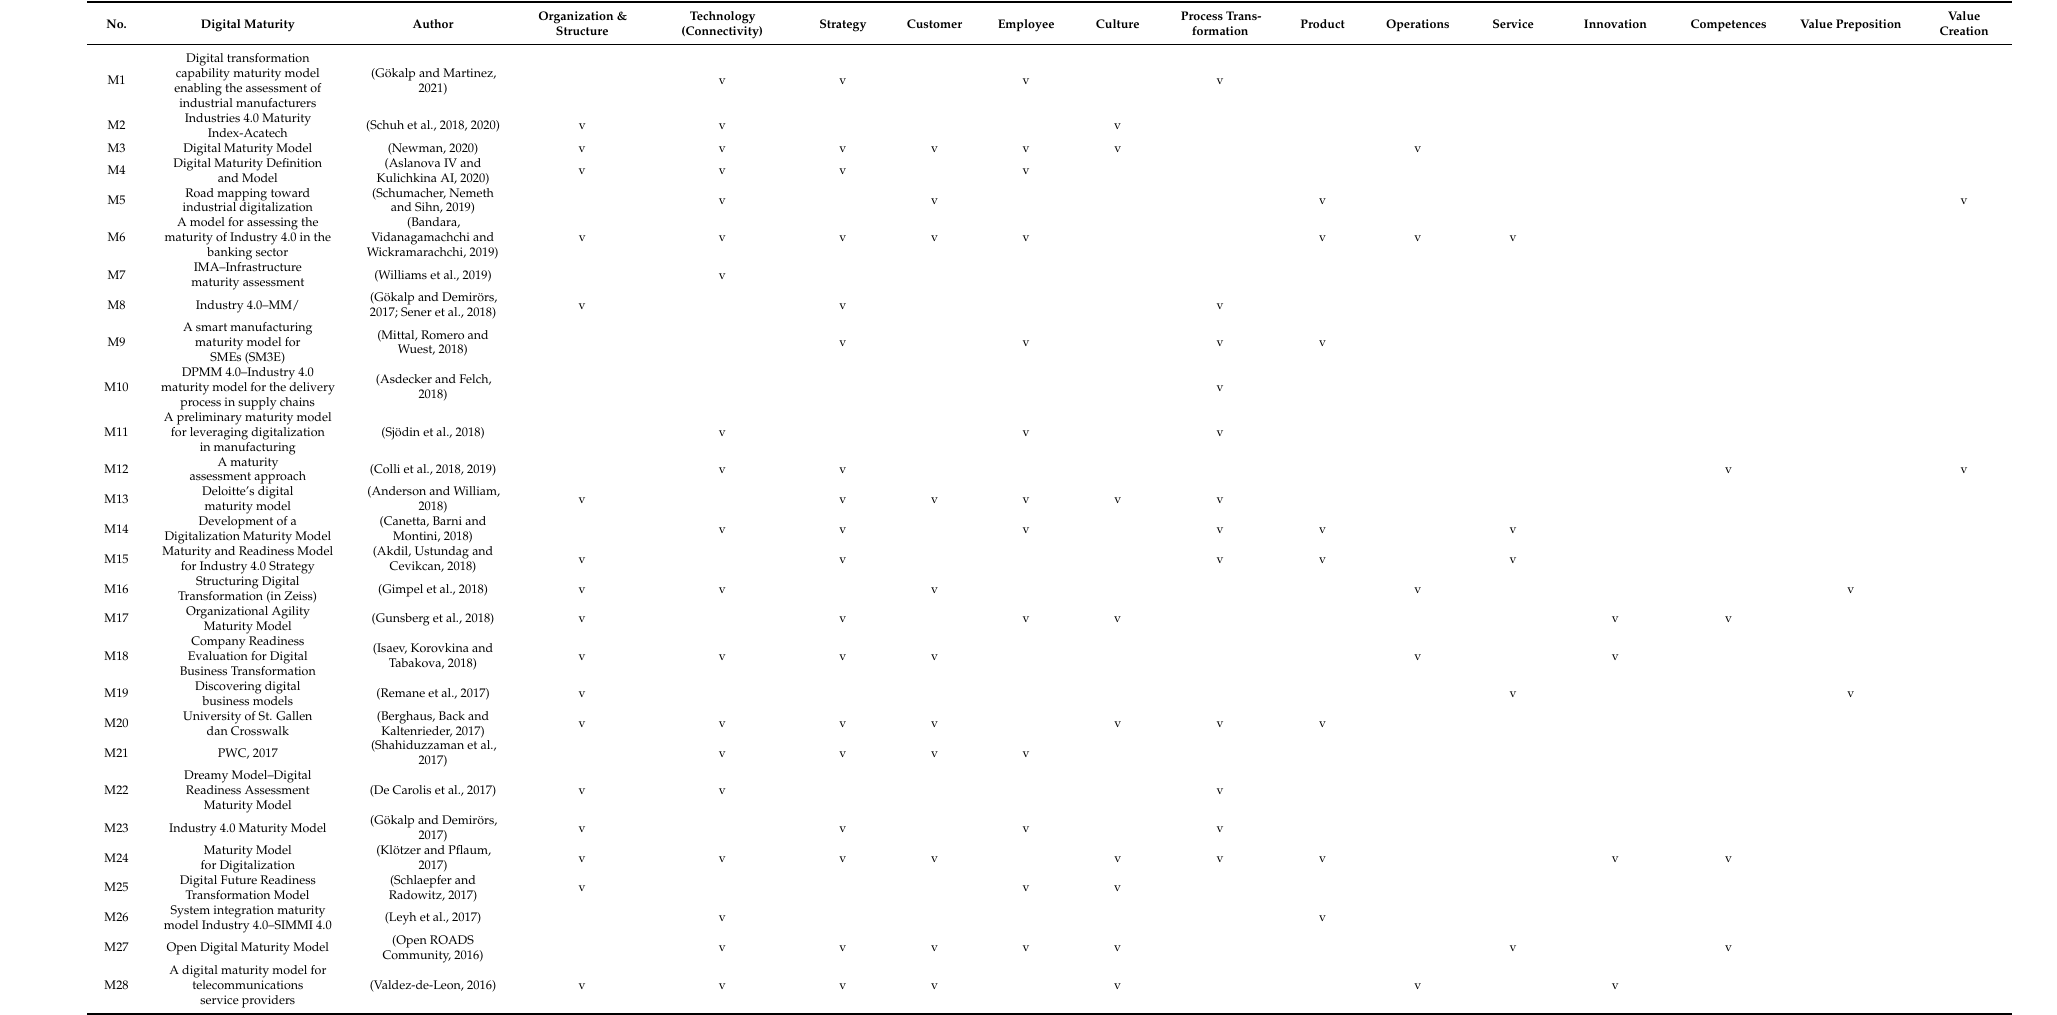
Table 2. The existing Digital Maturity